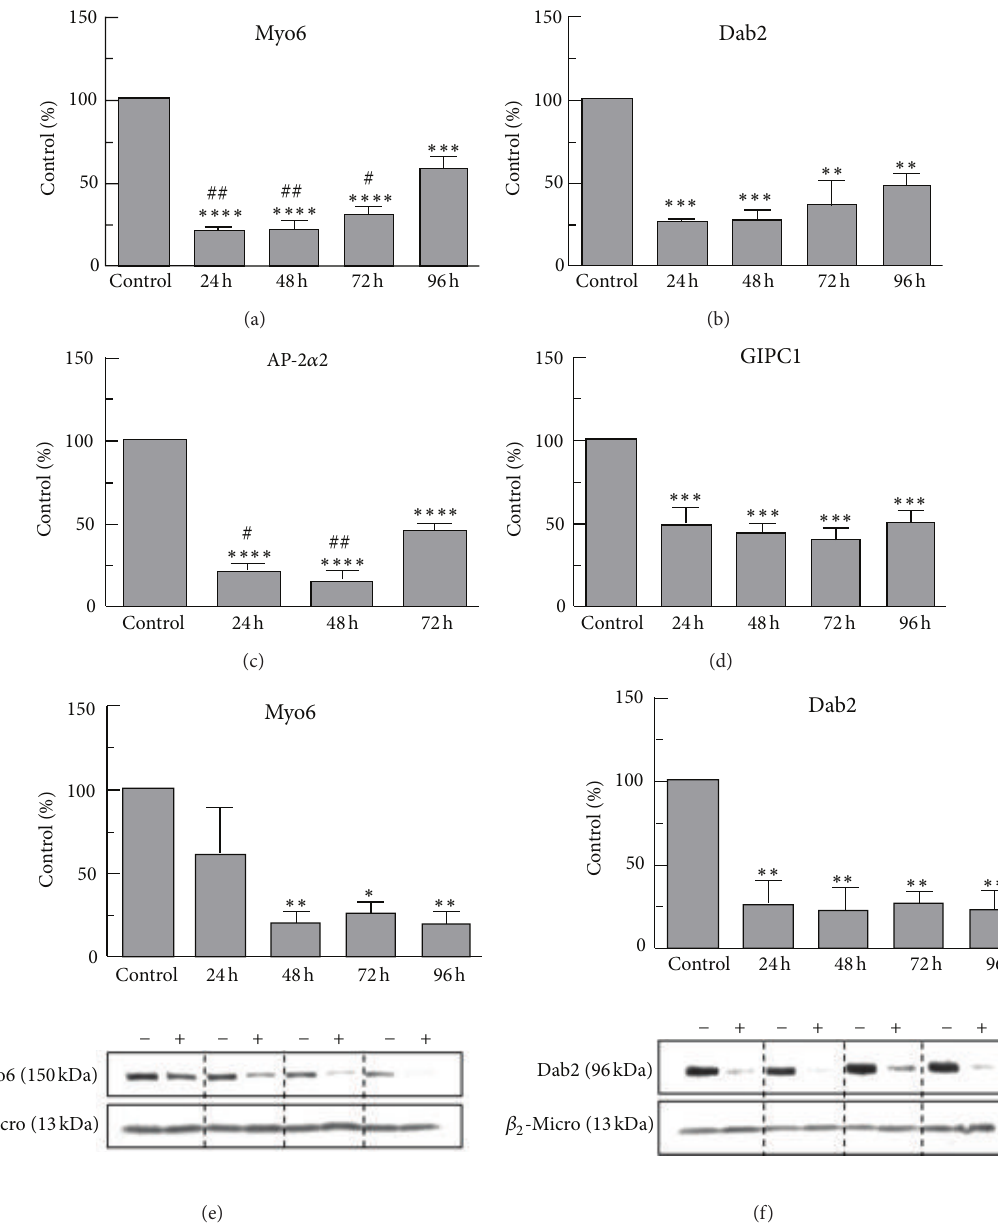
Figure 9: Inhibition of the expression of mRNA and protein for Myo6 and related proteins by siRNA. THP-1 macrophages were transfected with siRNA targeting Myo6, Dab2, AP-2 𝛼 2, GIPC1 or a nonsilencing scrambled siRNA sequence (control) using HiPerFect transfection reagent. Cells were lysed at 24 h–96h, and mRNA transcript levels for (a) Myo6, (b) Dab2, (c) AP-2 𝛼 2, and (d) GIPC were determined by qPCR, and the expression of protein for (e) Myo6 and (f) Dab2 was assessed by immunoblotting. Band density was quantified using Quantity One software (Biorad), and results are expressed as % control value. +, siRNA; − scrambled siRNA. Data shown are the mean from 3 separate experiments, and error bars show the SEM. Significance limits, ∗ 𝑃 < 0.05 , ∗∗ 𝑃 < 0.01 , ∗∗∗ 𝑃 < 0.001 , ∗∗∗∗ 𝑃 < 0.0001 versus control; # 𝑃 < 0.05 , ## 𝑃 < 0.01 versus 96h (one-way